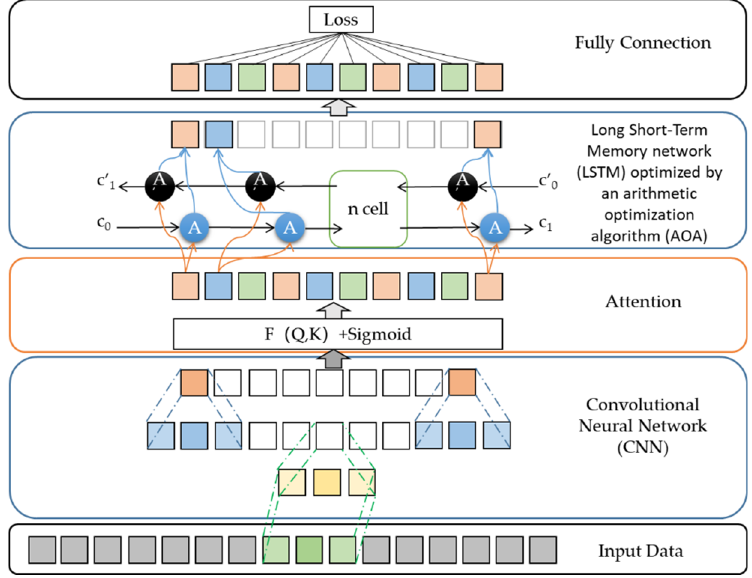
Figure 1. CNN-AOA-LSTM food security risk level prediction model based on the attention mechanism.